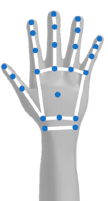
Figure 5. The 17 recognizable joints of the Astra S. Figure 6. The 25 recognizable joints of the Leap Motion.